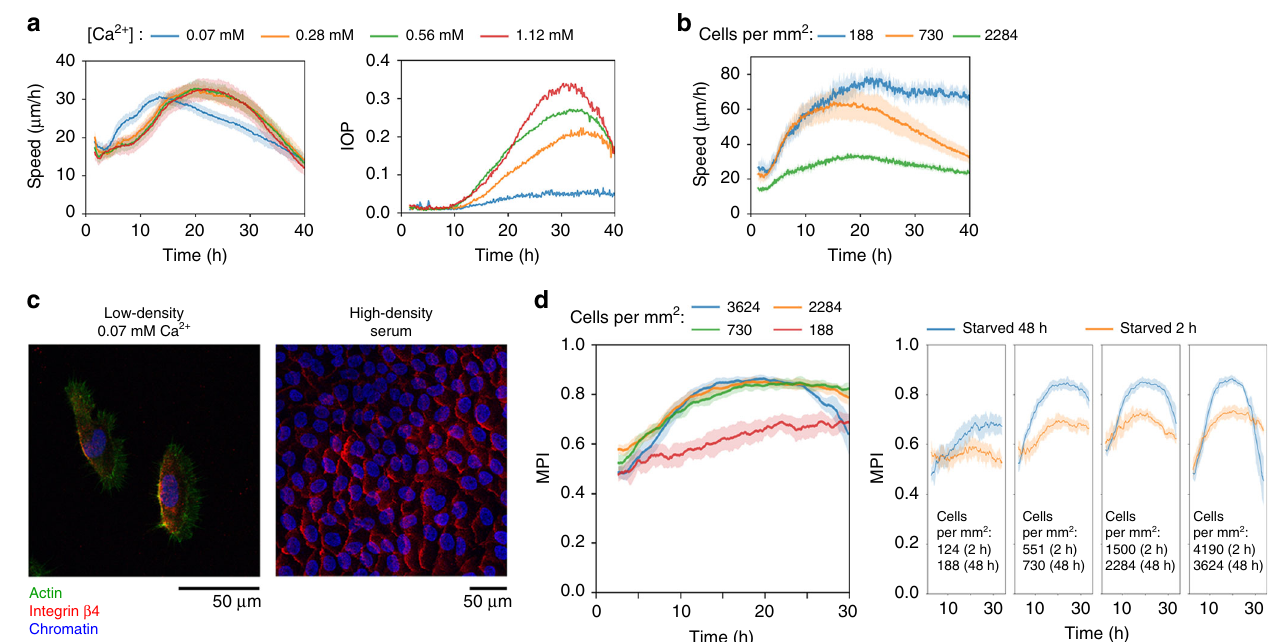
Fig. 2 Polarized self-propelled cells drive collective migration. a Quiescent cell sheets were stimulated in the presence of EGF and varying calcium concentrations. Average speed and IOP were obtained from particle tracking and PIV analysis, respectively. Mean ± SD (speed) and mean values (IOP) are shown; n = 3 experiments. b Average migration speed generated at different cell densities in the presence of EGF and low calcium concentration. Cells were starved for 48 h prior to stimulation. Mean ± SD are shown; n = 3 experiments. Average cell densities at time = 0 are indicated. c Integrin β 4 polarity was visualized by IF in fi xed cells following 48 h of serum deprivation and 16 h of stimulation. Left panel: Cells plated at low density and stimulated in the presence of EGF and 0.07 mM calcium. Right panel: Cells plated at con fl uent densities and stimulated with serum. d Migration persistency index (MPI) over time was generated from particle tracking data. Cells plated at different densities were stimulated in the presence of EGF and 0.07 mM calcium. Left panel: Cells starved for 48 h. Right panels: Comparison of cells starved for 48 h and 2 h. Mean± SD are shown; n = 3 experiments. Average cell densities at time = 0 are